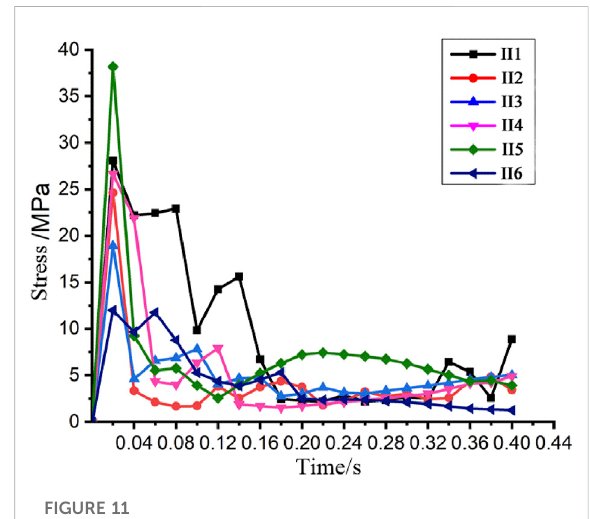
FIGURE 11 Stress − time history curve of the tower foundation under different working conditions.